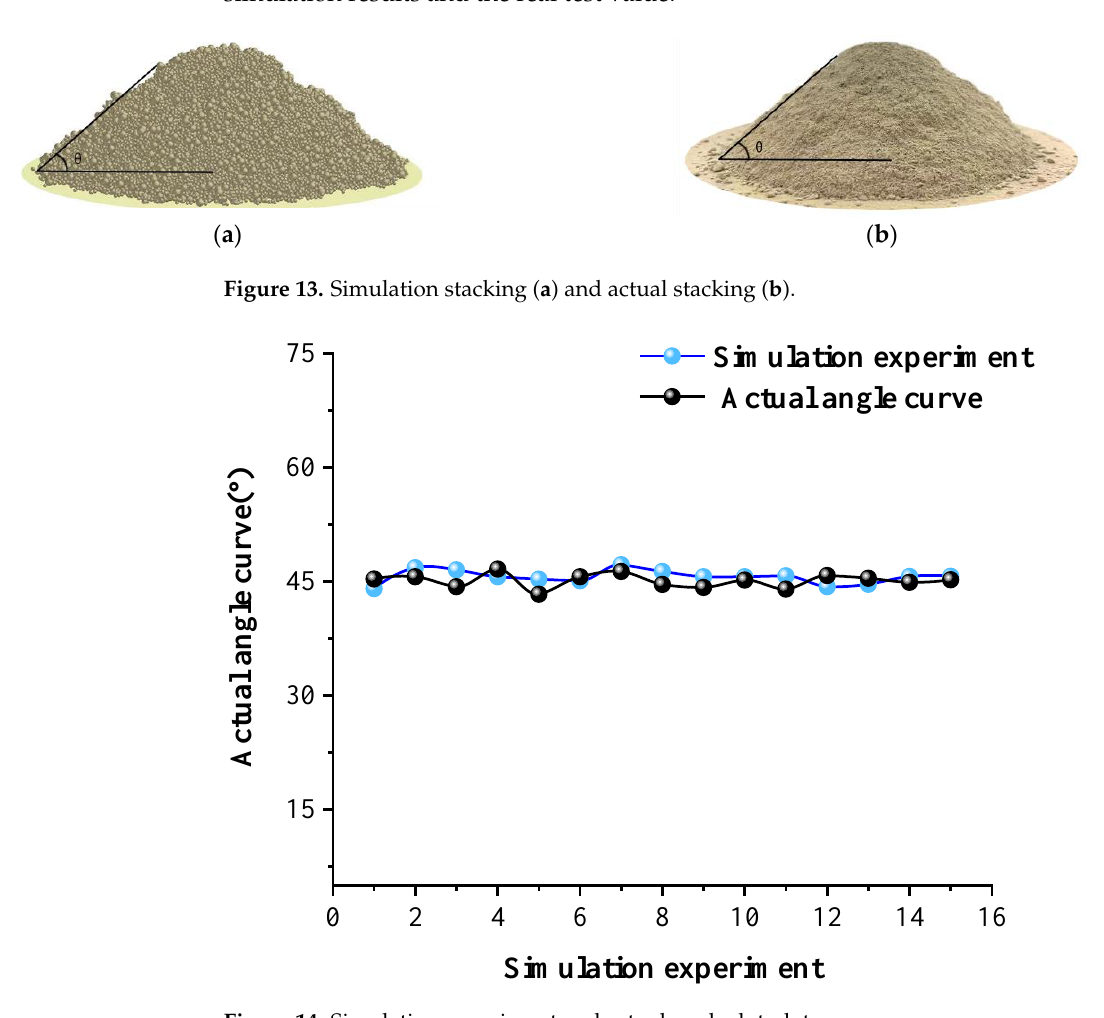
Figure 14. Simulation experiment and actual angle dot plot.